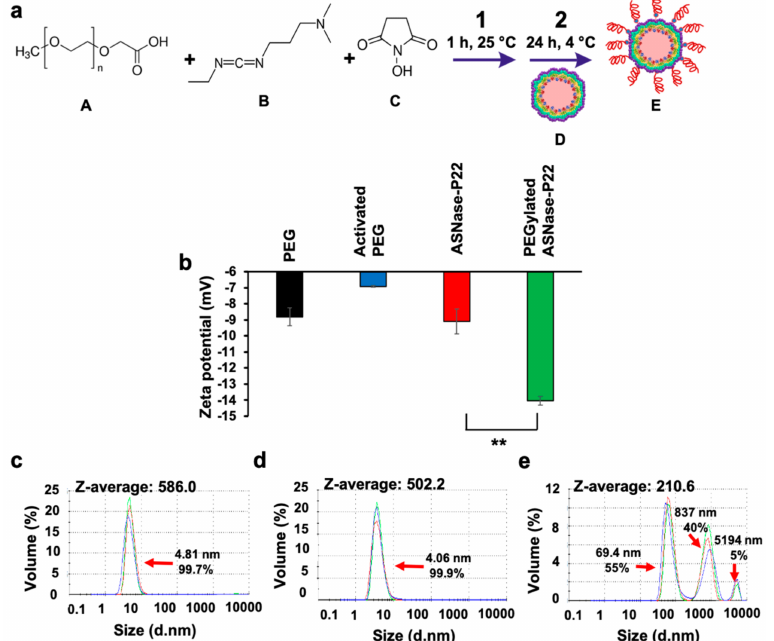
Figure 6. PEGylation of ASNase-P22 nanoreactors. ( a ) PEGylation reaction of ASNase-P22 nanoreac- tors. Molecule A: PEG carboxylic acid; B: 1-Ethyl-3-(3-dimethylaminopropyl)carbodiimide (EDC); C: N-hydroxysuccinimide (NHS); D: P22-based VLP; E: PEGylated ASNase-P22 nanoreactor. ( b ) Zeta- potential measurements of PEG, activated PEG (as negative controls), non-PEGylated and PEGylated ASNase-P22 nanoreactors. Error bars represent the standard deviation. (**) p < 0.01. Size particle measurements of ( c ) PEG and ( d ) activated PEG (as negative controls) and ( e ) PEGylated ASNase-P22 nanoreactors. The figure shows a representative DLS profile of at least n = 3. Z-averages, particle sizes (nm), and percentage of volume (mL) for each case are indicated in the